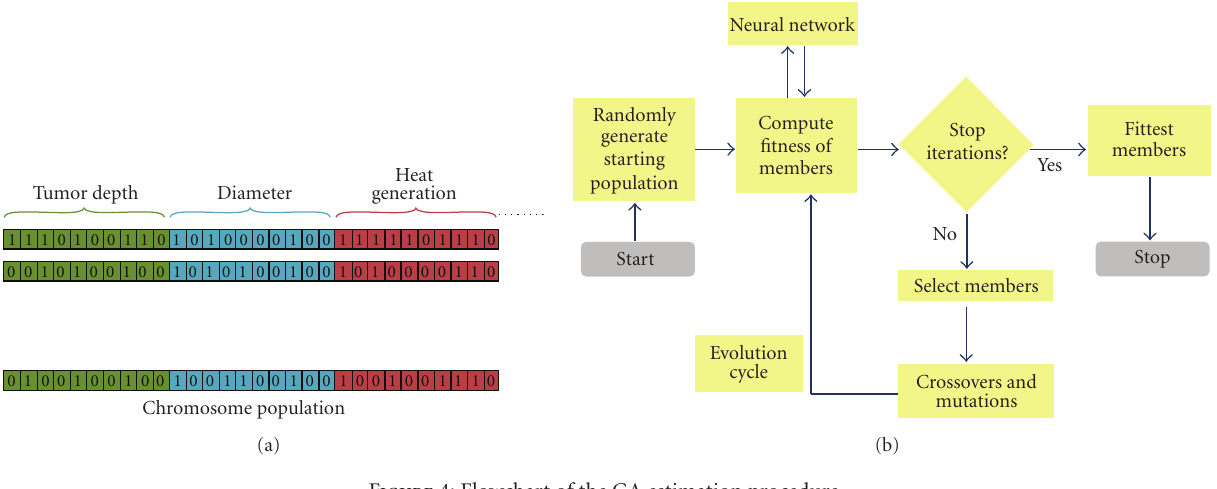
Figure 4: Flowchart of the GA estimation procedure. Table 1: Values of thermal conductivity, metabolic heat generation, and perfusion term.